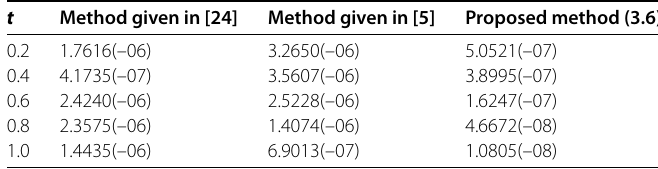
Table 6 Example 1: Case 1.2(c): Maximum absolute errors at δ =